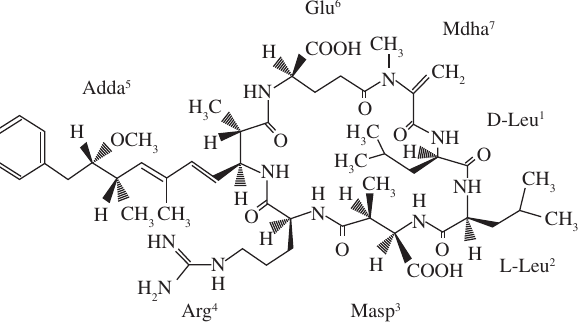
Figure 3. Structure of the [D-Leucine 1 ]MCYST-LR. Table 3. Parameters of the kinetic models of Lagergren-first-order, Pseudo-second-order and Elovich. Moldels